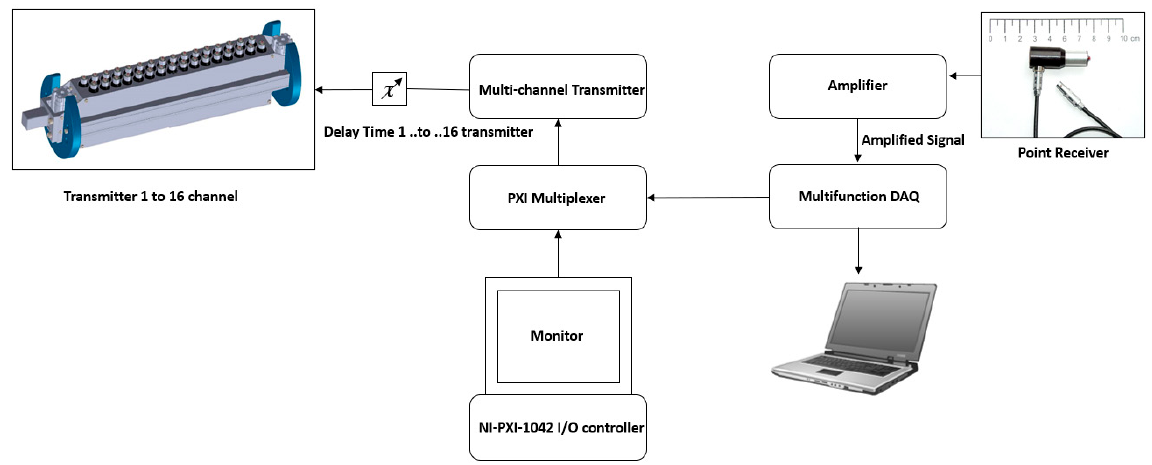
Figure 11. Data Acquisition of third generation borehole probe for directivity measurement.